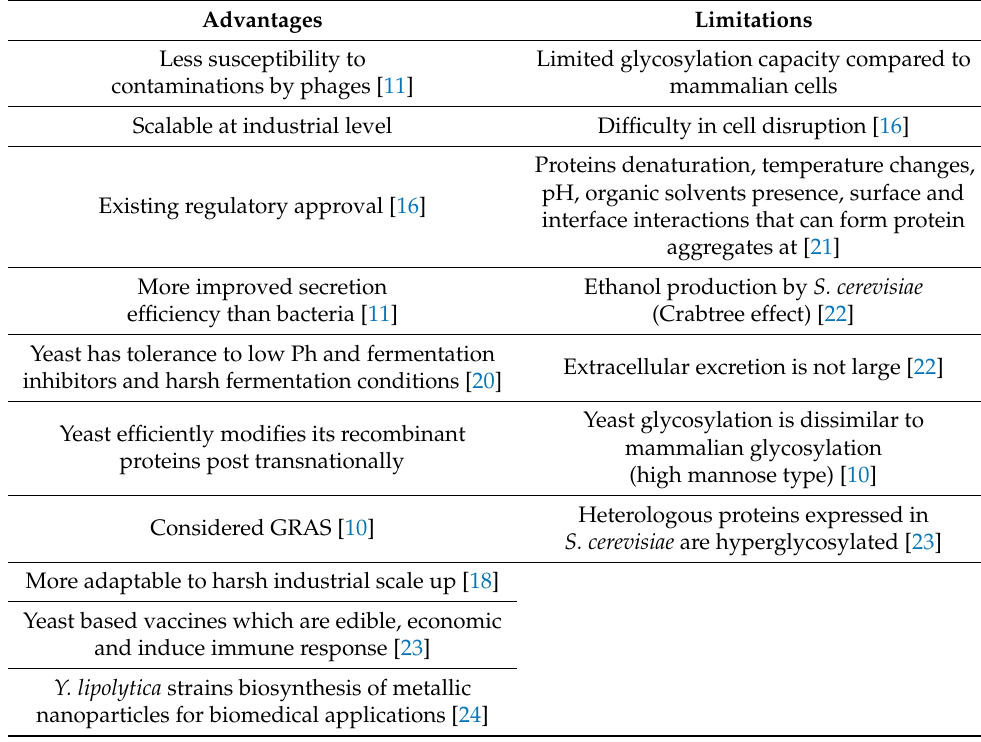
Table 2. Outlining the advantages and limitations of yeast expression systems in the production of biologics. Advantages